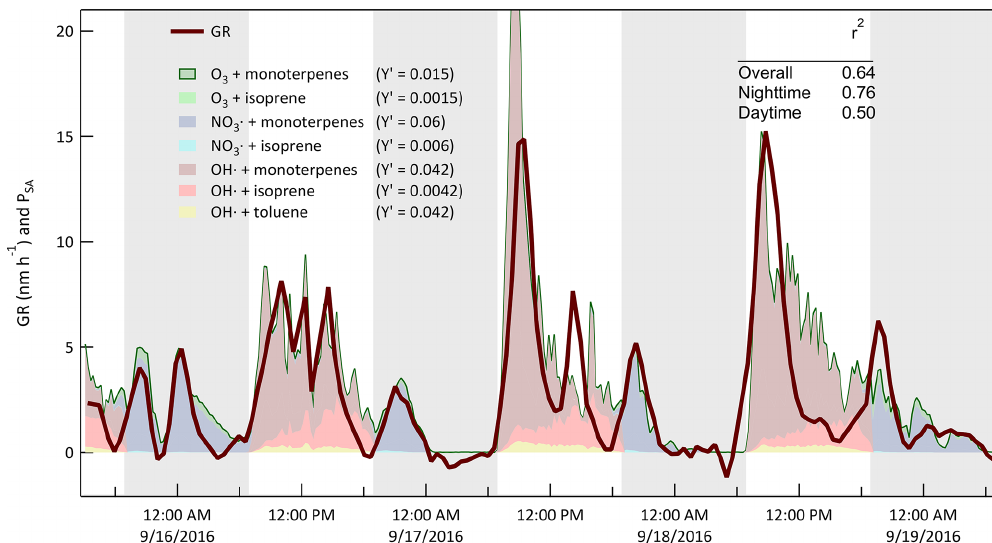
Figure 18. Measured diameter growth rate (GR) and calculated secondary aerosol production rate ( P SA ) for the same 3.5d example period described above. Effective aerosol yields for the reactions considered were adjusted to minimize differences between the values of GR (in